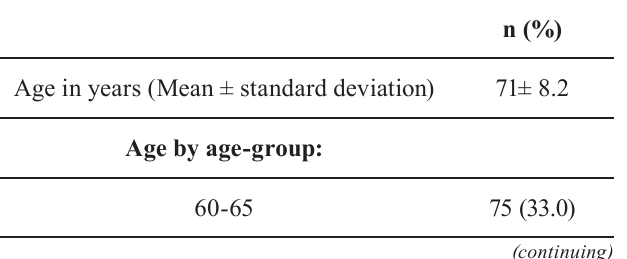
TABLE I – C linical characteristics of the study population